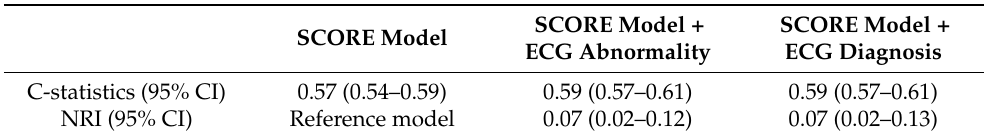
Table 5. Model comparison of the SCORE model alone and of the SCORE model with ECG abnor- mality or detailed